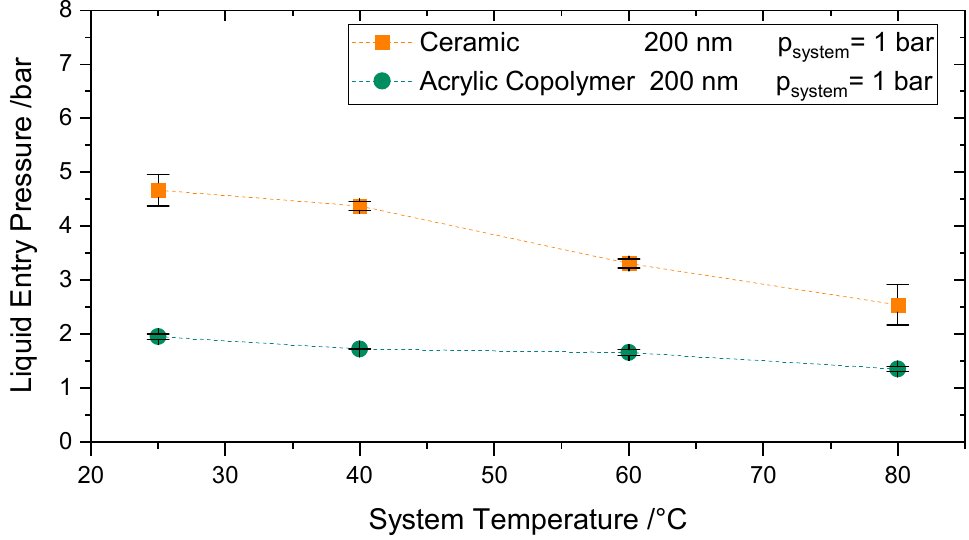
Figure 10. Influence of system temperatures up to 80 °C on Liquid Entry Pressure for a Versapor Membrane 200 (Green) and Ceramic Membrane 200 (Orange).